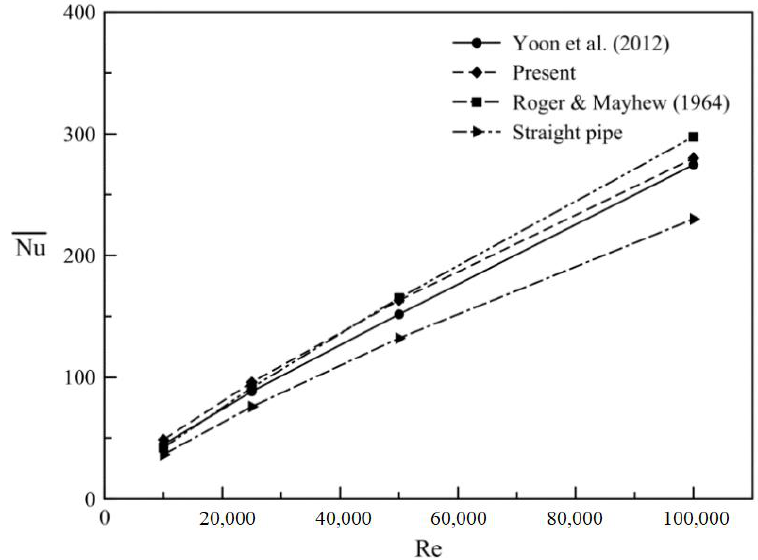
Figure 6. Average Nusselt number for various Reynolds numbers.